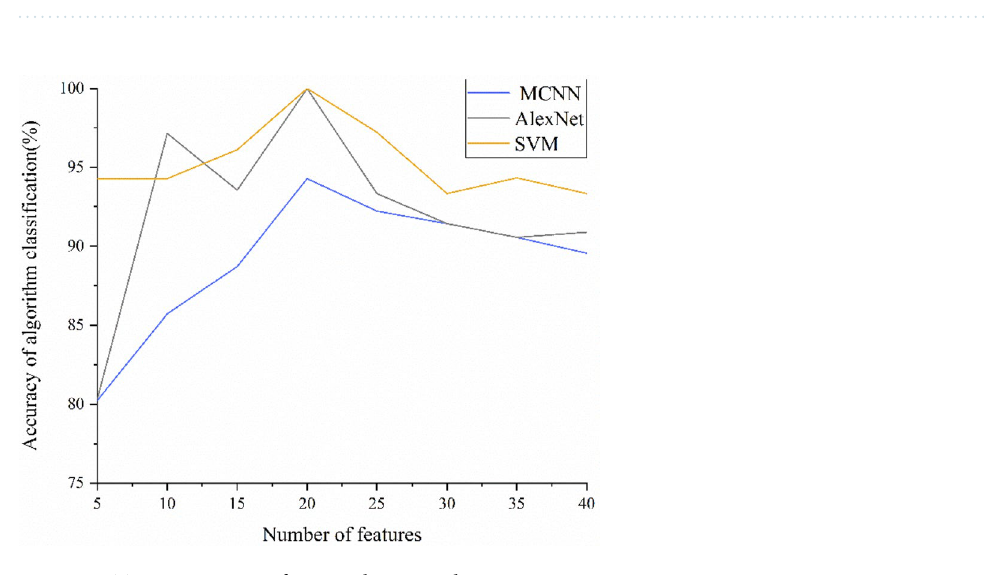
Figure 6. Test set accuracy of SVM, AlexNet and